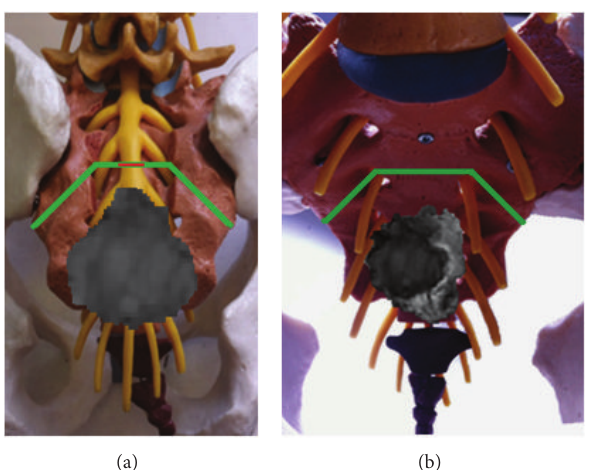
Figure 10: Representation in a model of the 3 osteotomies performed (green lines) and the level of thecal sac ligation (thin red line). (a) Posterior view and (b) anterior view.